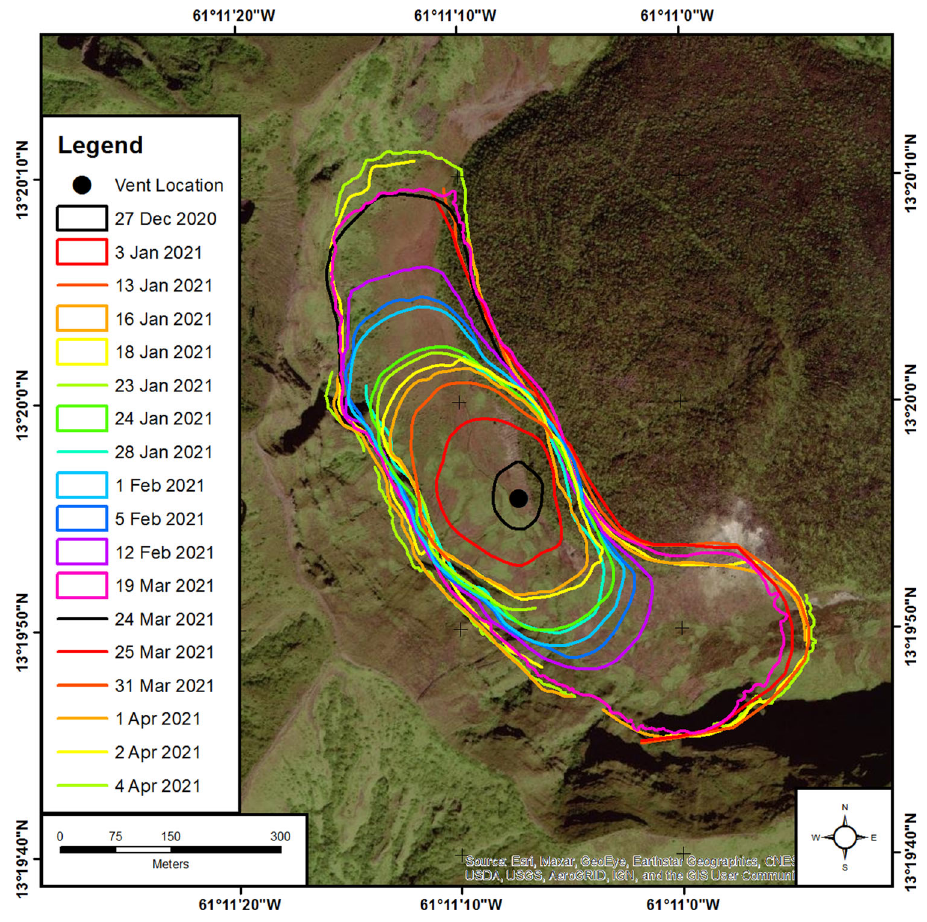
Fig. 9 Footprints of the 2020 – 2021 lava dome of La Soufrière volcano, St. Vincent. A map of the summit crater of La Soufriere, St Vincent, showing full and partial footprints for the new lava dome that fi rst appeared on 27 December 2020. Footprints were extracted from multispectral and radar satellite imagery, oblique aerial and terrestrial photographs and drone surveys. Background is pre-eruption imagery that shows the 1979 lava dome inside the summit